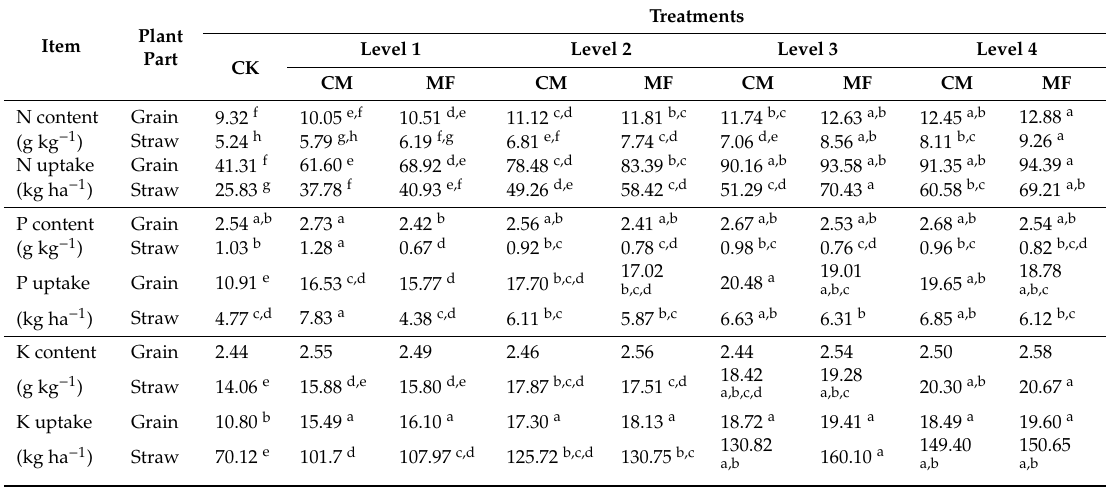
Table 4. Average N, P and K contents and uptakes in maize in response to di ff erent fertilization treatments over 10